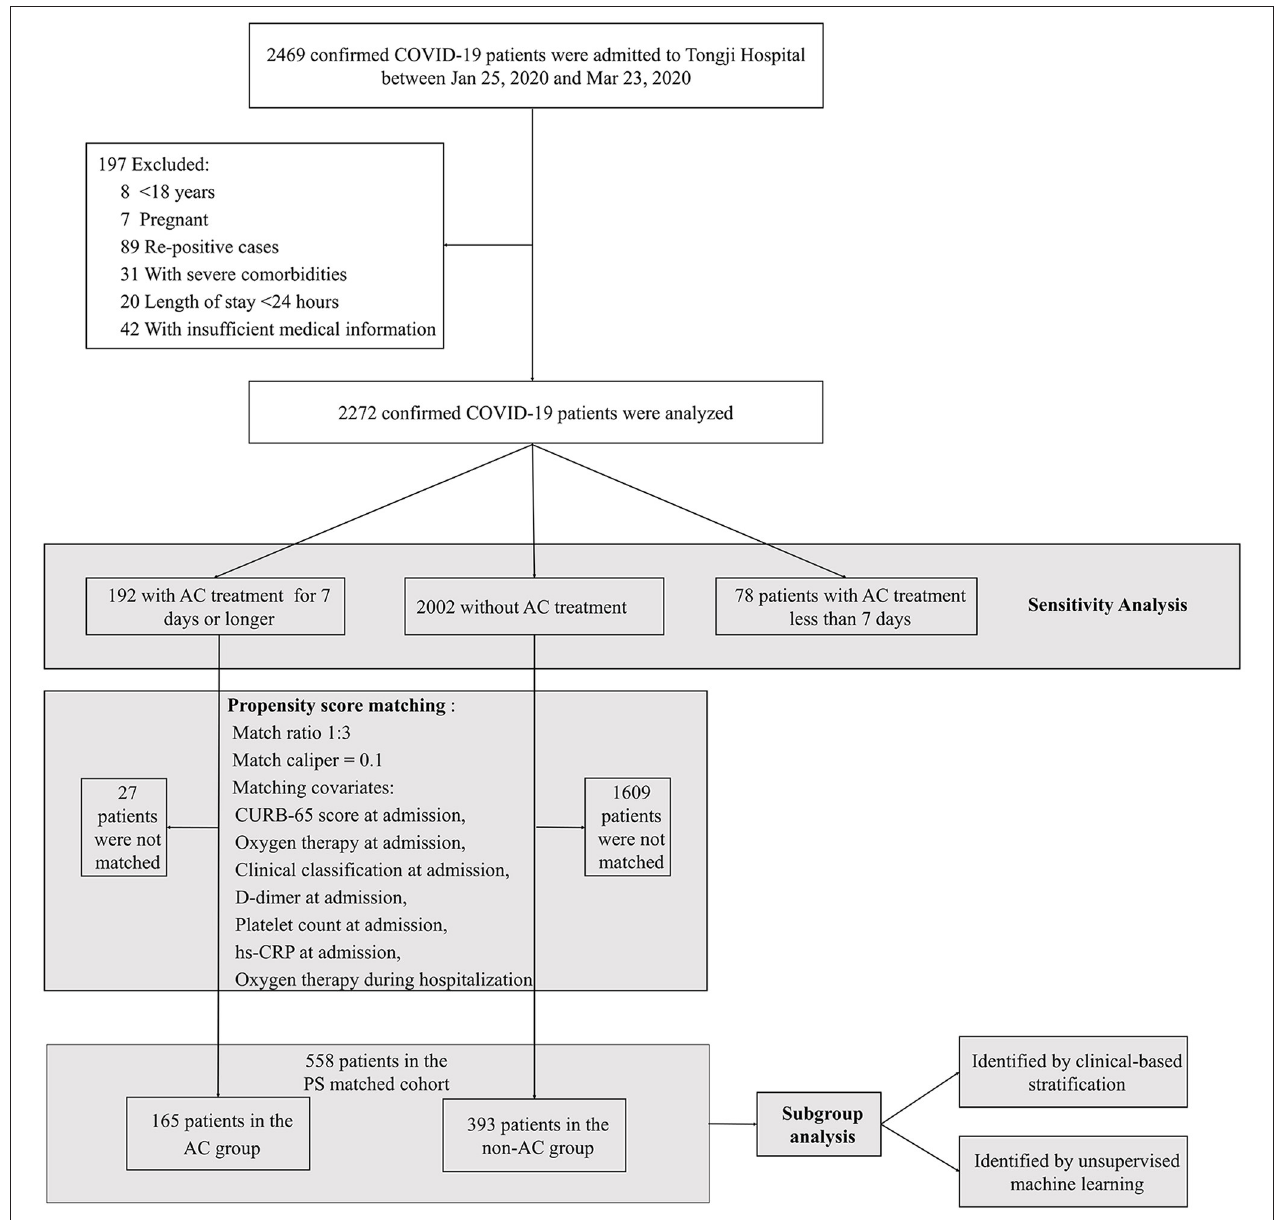
FIGURE 1 | Flow diagram of the study. COVID-19, Coronavirus Disease 2019; AC, anticoagulation; hs-CRP, high sensitivity C-reactive protein; PS, propensity score.